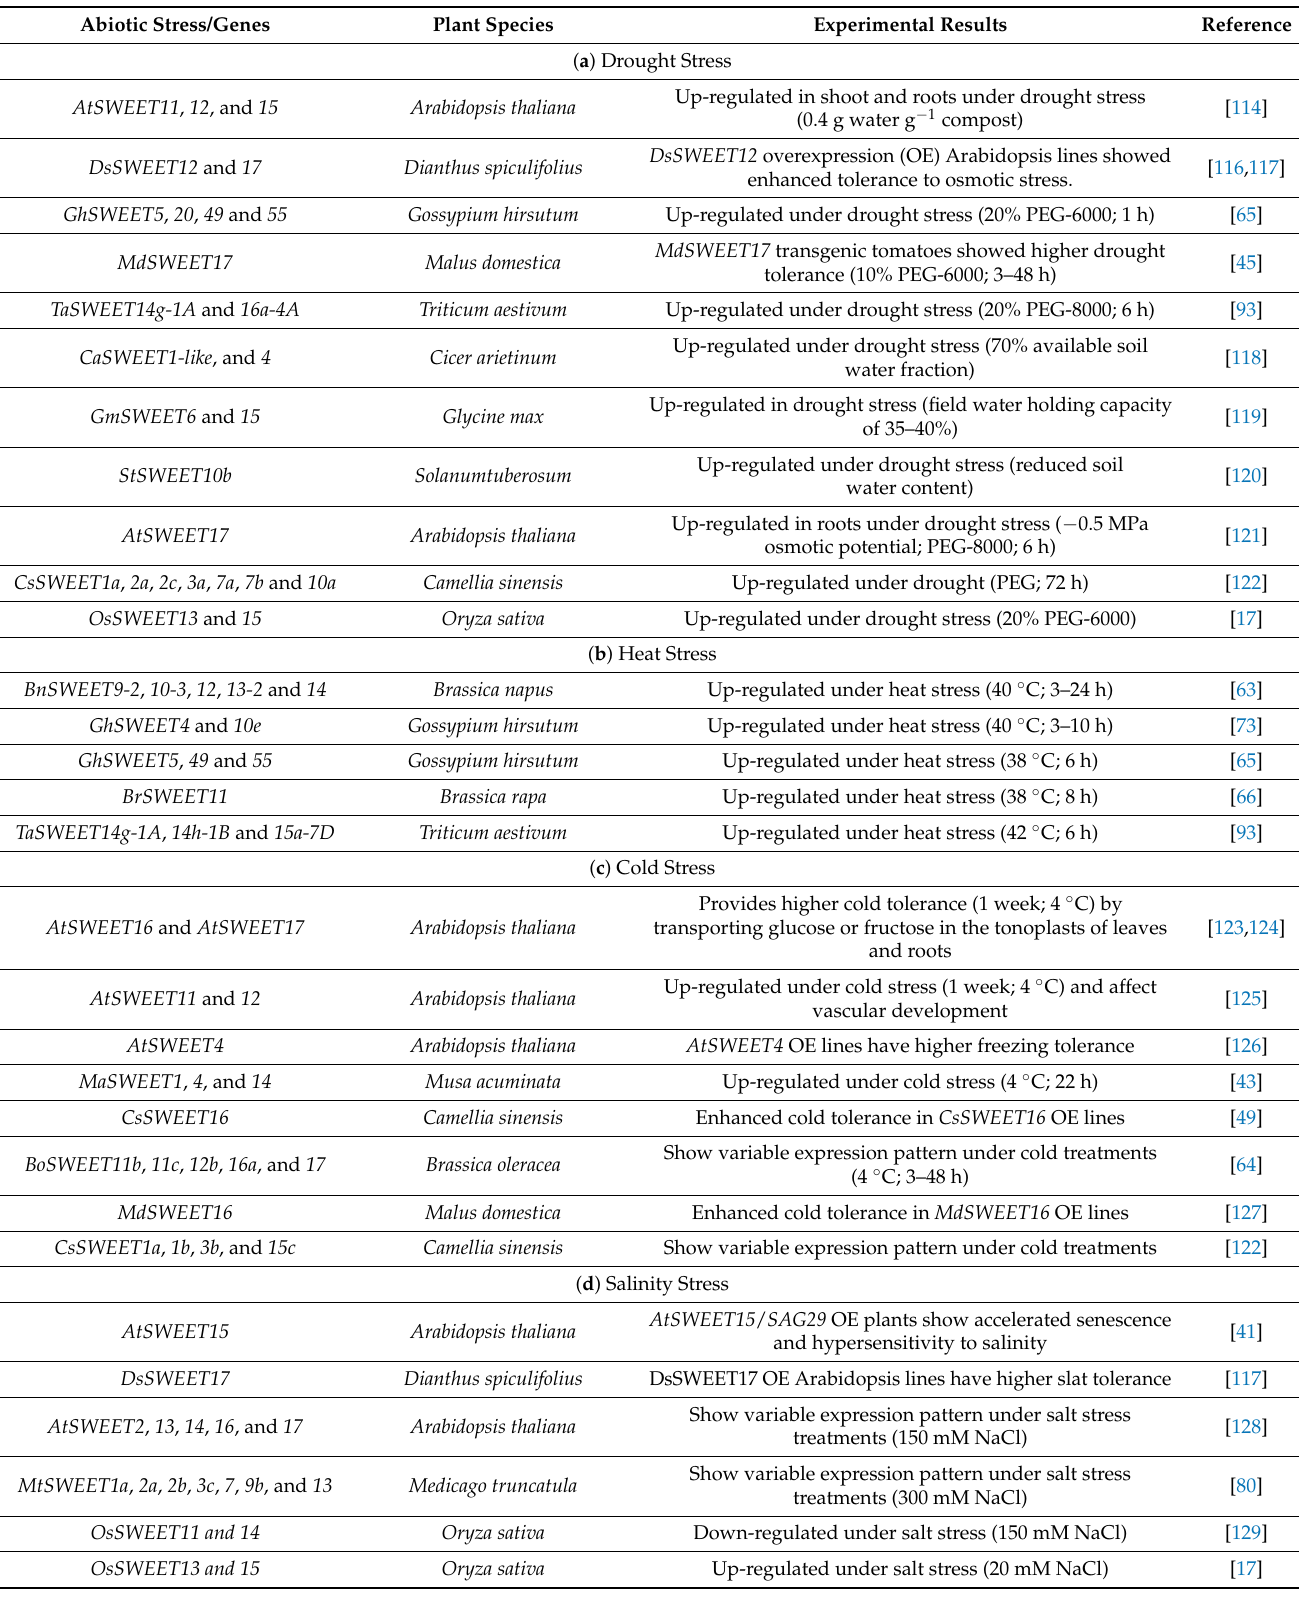
Table 1. List of important SWEET sugar transporters genes in plants involved in different abi- otic